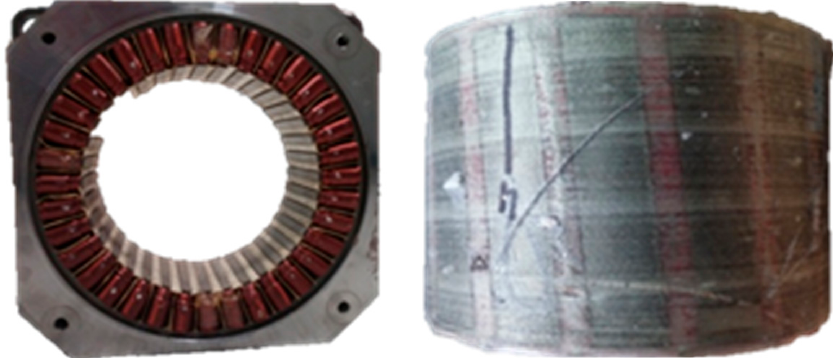
Figure 23. Rotors and stators of the prototype built for Qs48p8.